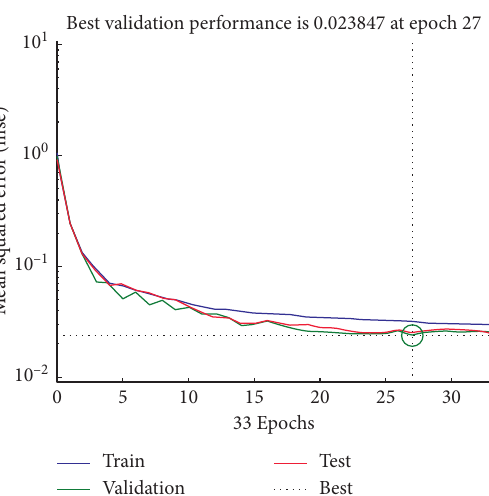
Figure 4: Borehole distribution.